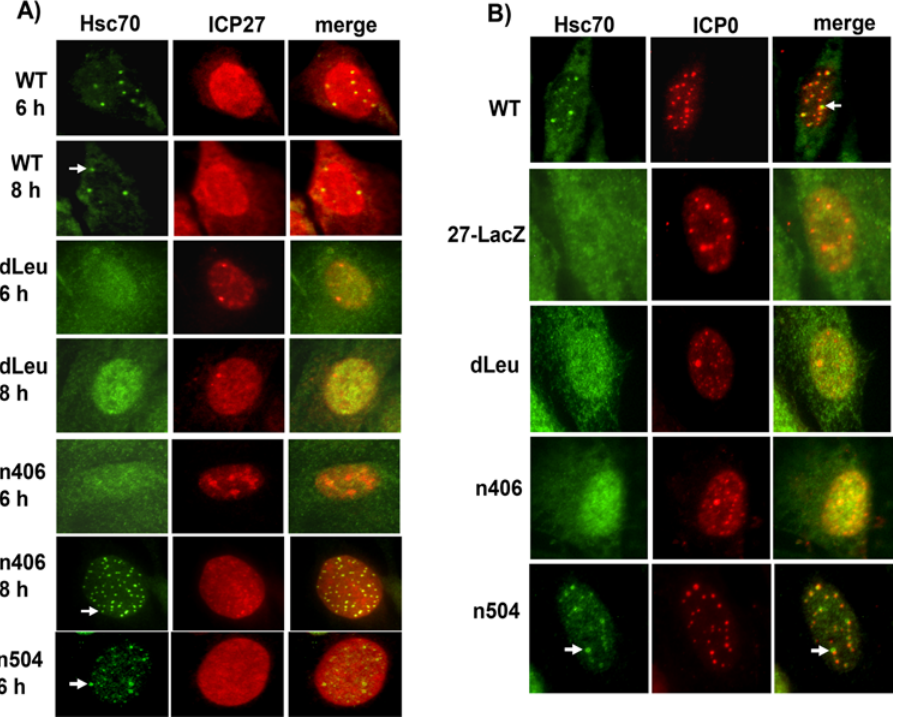
Figure 4. Hsc70 Nuclear Focus Formation Is Delayed in Infections with ICP27 Mutants. A) Vero cells were infected with WT HSV-1 or mutants dLeu, n406 or n504. At the times indicated, cells were fixed and stained with anti-Hsc70 and anti-ICP27 antibodies as indicated. Arrows mark Hsc70 nuclear foci. B) Vero cells were infected with WT HSV-1, 27-LacZ, dLeu, n406 or n504 for 6 h, at which time cells were fixed and stained with anti-Hsc70 and anti-ICP0 antibodies. The arrow marks an Hsc70 focus adjacent to an ICP0